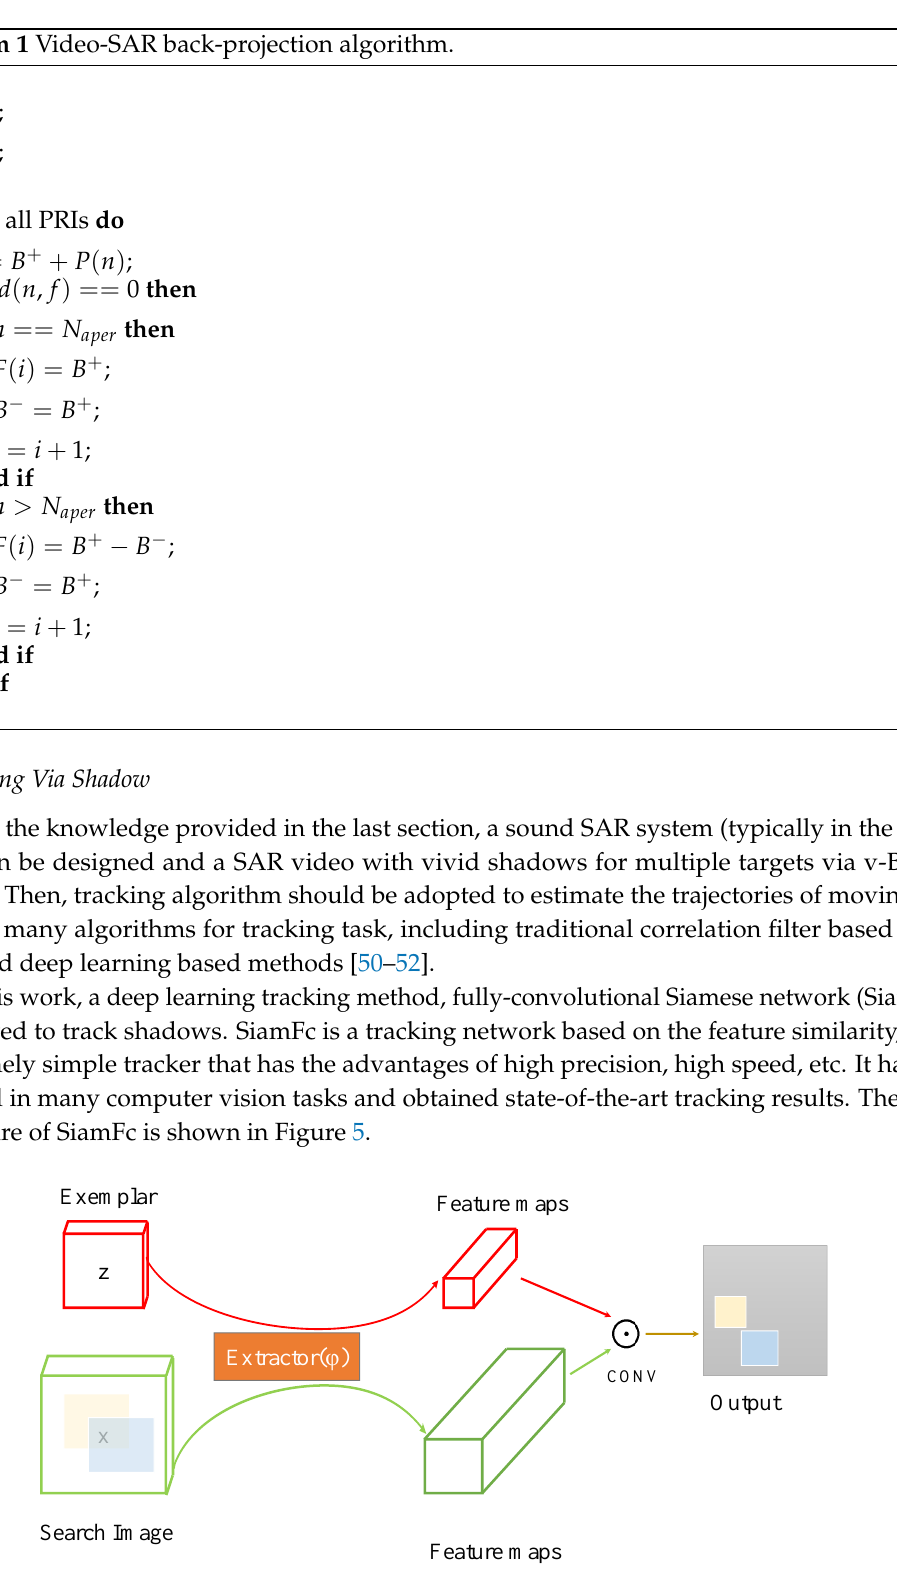
Figure 5. Network architecture of